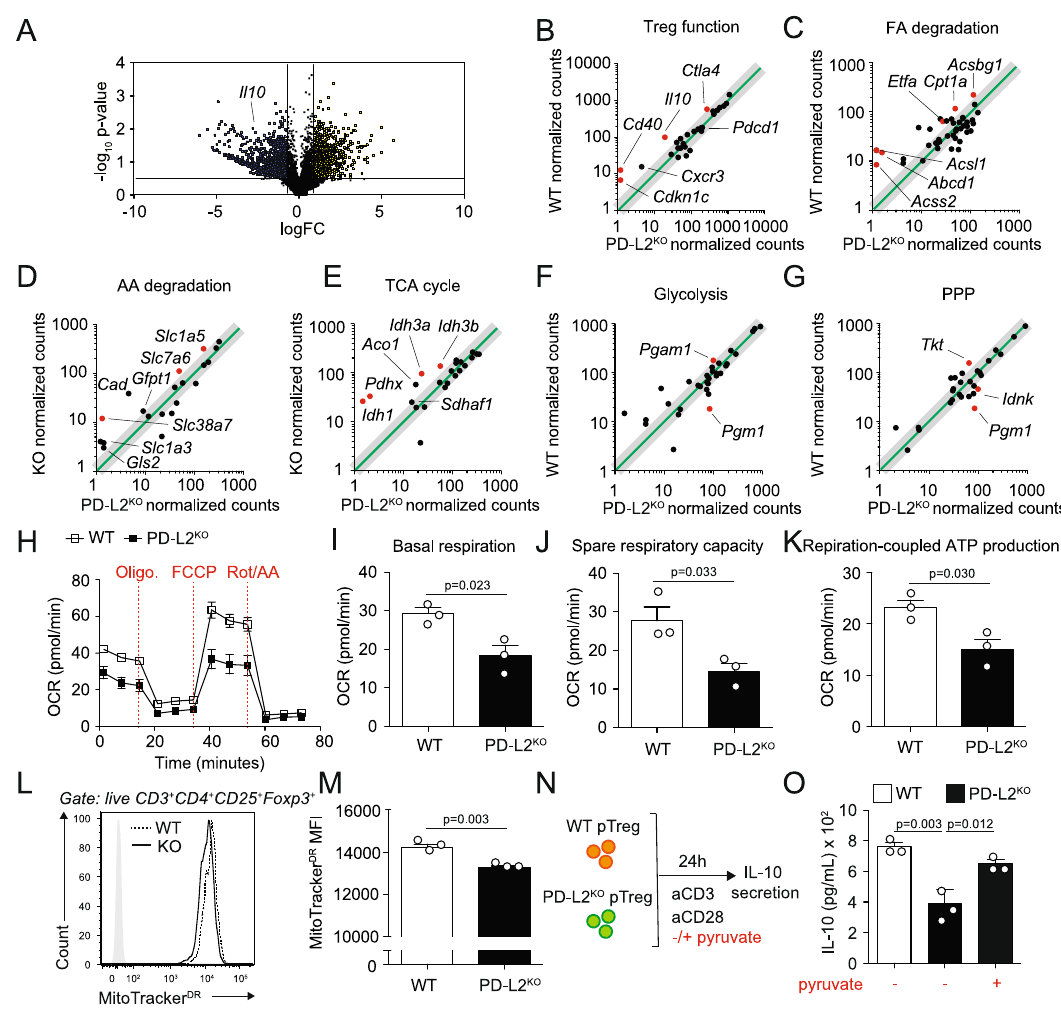
Fig. 5 | PD-L2 modulates pTreg signature genes and metabolic function. A CD3 + CD4 + CD25 + Foxp3 GFP+ Nrp1 − splenic pTregs cells were FACS-sorted from the spleens of Foxp3 GFP and PD-L2 KO Foxp3 GFP mice and incubated for 24h with CD3/ CD28 beads, IL-2 and TGF- β . Cells were then lysed and mRNA was isolated to perform RNA-sequencing (RNA-seq). Volcano plot representation of differentially regulatedgenes in WT and PD-L2 KO pTregs. Dotted lines represent 2FC ( x axis) and p <0.05 ( y axis) cutoffs. B – G Differentially regulated genes in selected pathways. B Tregfunctionpathway. C Fattyacid(FA)degradationpathway. D Aminoacid(AA) degradation pathway. E TCA cycle pathway. F Glycolysis pathway. G Pentose Phosphate Pathway(PPP) pathway. All red dots represent genes whose differences are p <0.05. H – K CD3 + CD4 + CD25 + Foxp3 GFP+ Nrp1 − splenic pTreg cells were